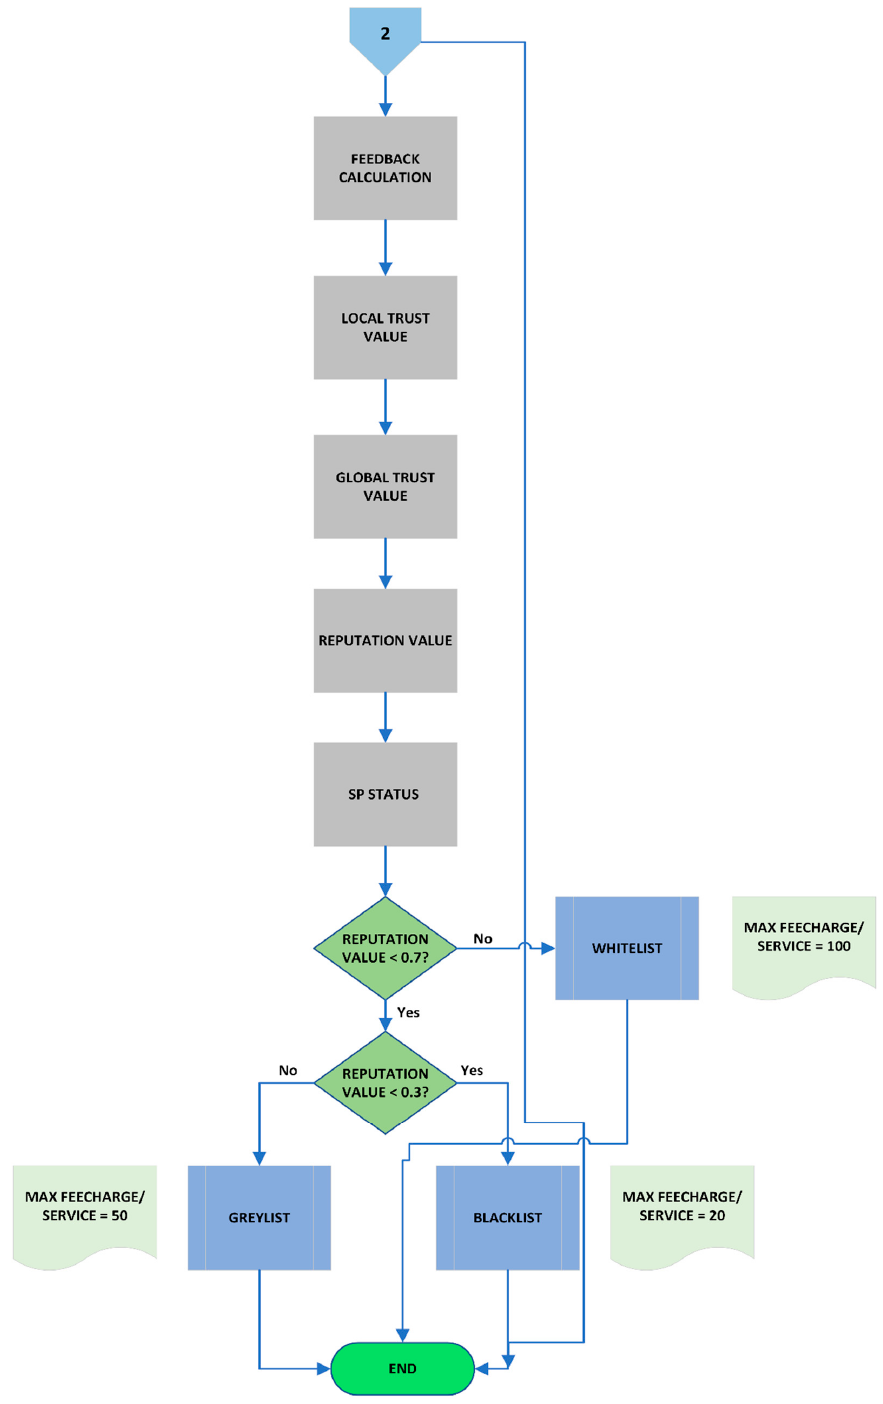
Figure 3. Flow Chart for Our Trust and Reputation Management Framework.